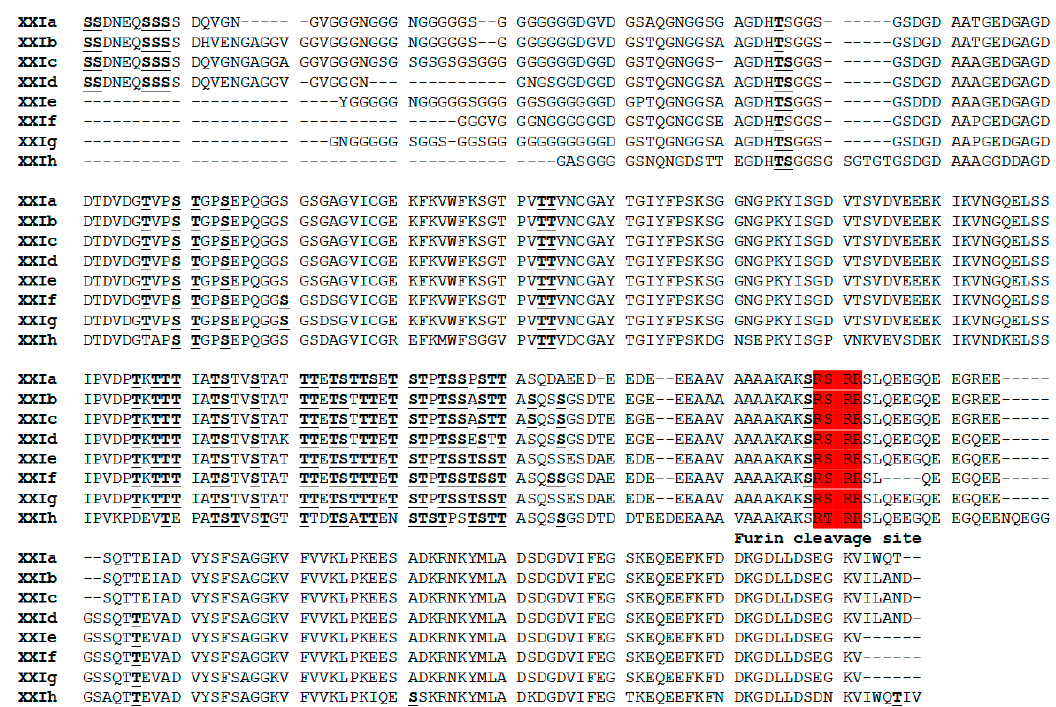
Figure 2. Phylogeny among eight Cryptosporidium ryanae subtype families based on a maximum likelihood analysis of the partial gp60 gene. Sequences from dairy cattle, beef cattle, yaks, and water buffaloes are marked in black, green, red, and blue, respectively. Bootstrap values (>75) are indicated on branches. Scale bar indicates 0.02 nucleotide substitutions per site.